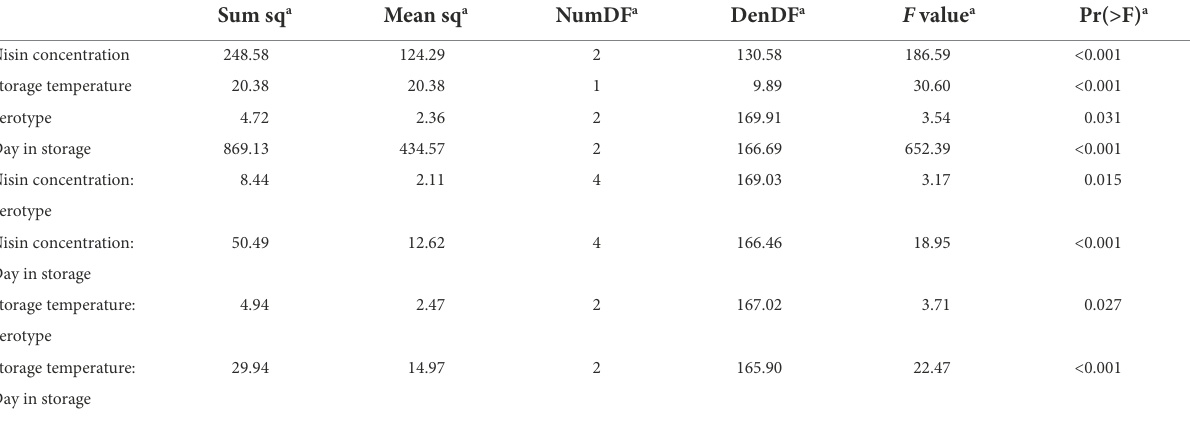
TABLE 3 Two-way ANOVA summary of the mixed effects linear model (Level